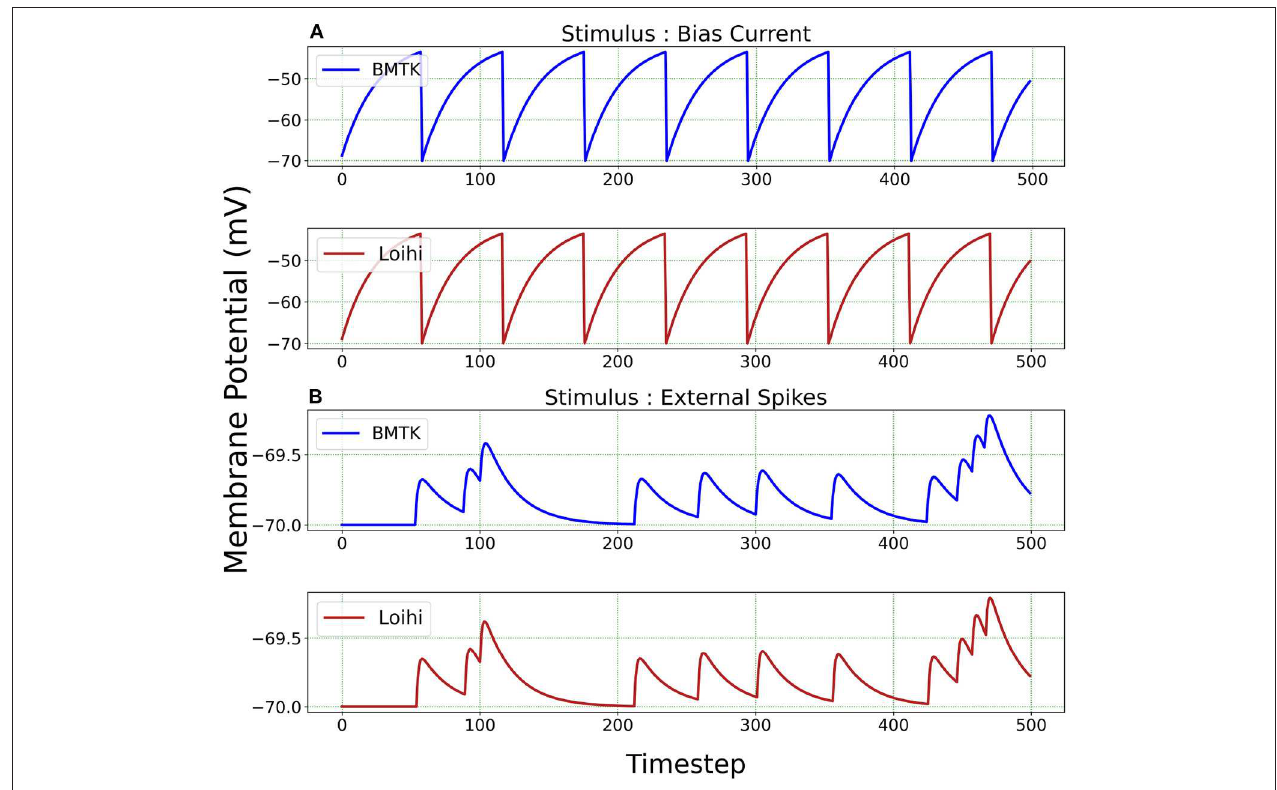
FIGURE 3 | Membrane potential response for single-neuron network based on two different neuron parameters. (A) Simulation is driven by bias current. (B) Simulation is driven by external spikes.